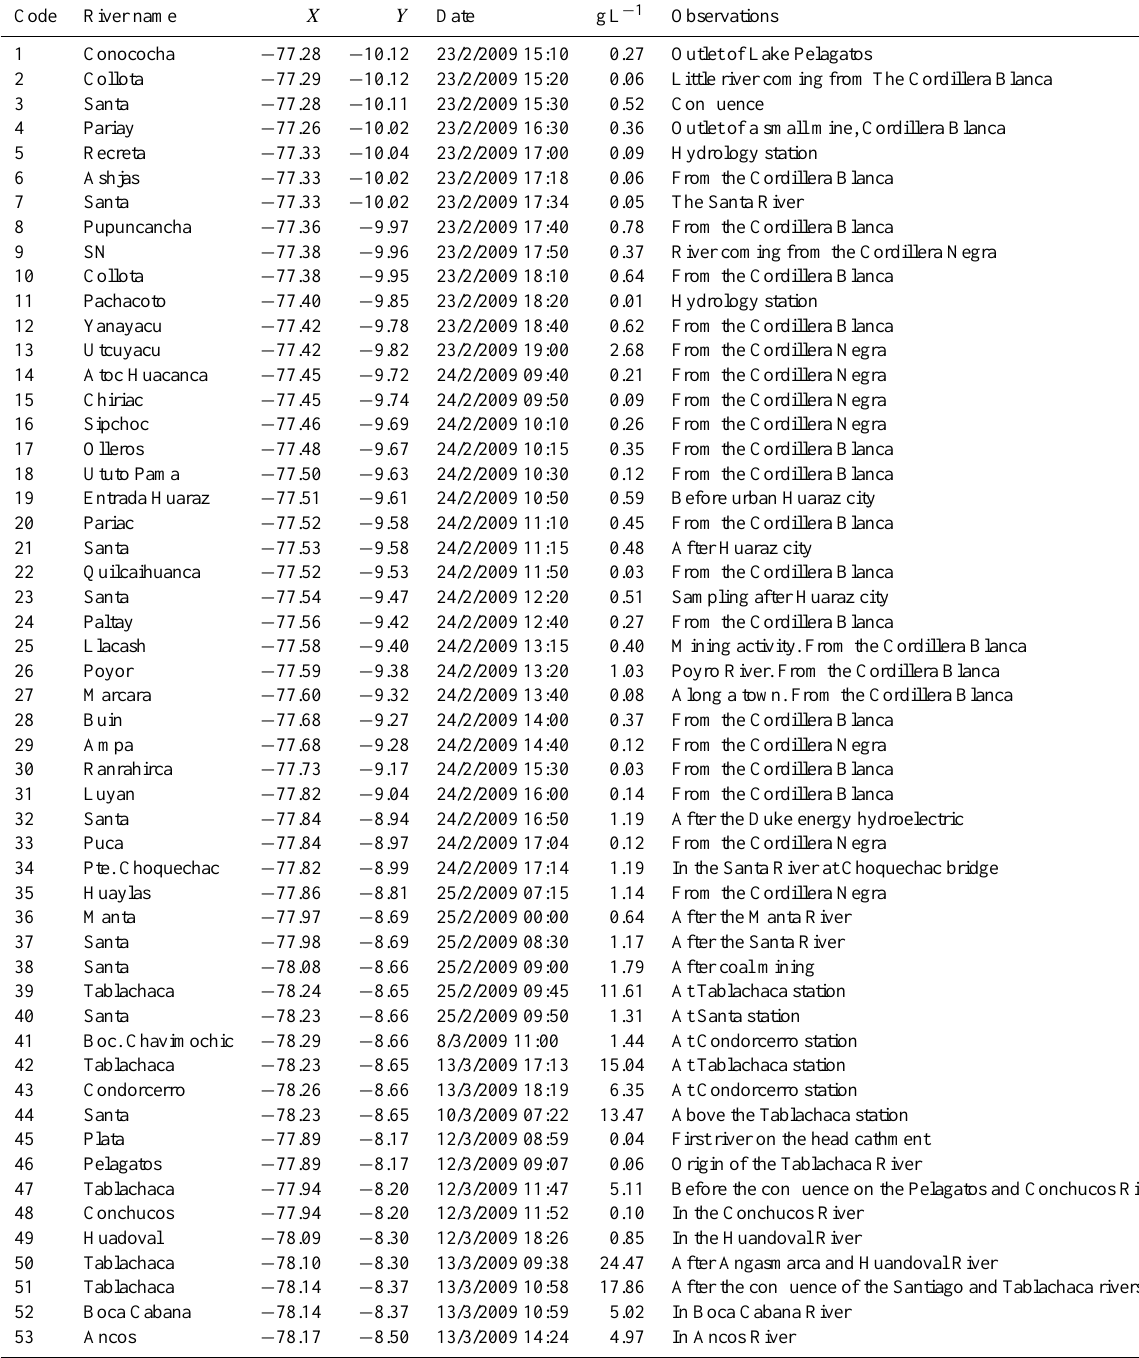
Table 2. Sites where samples were collected during the wet season 2009 (February–March) in the Santa and Tablachaca study catchments.